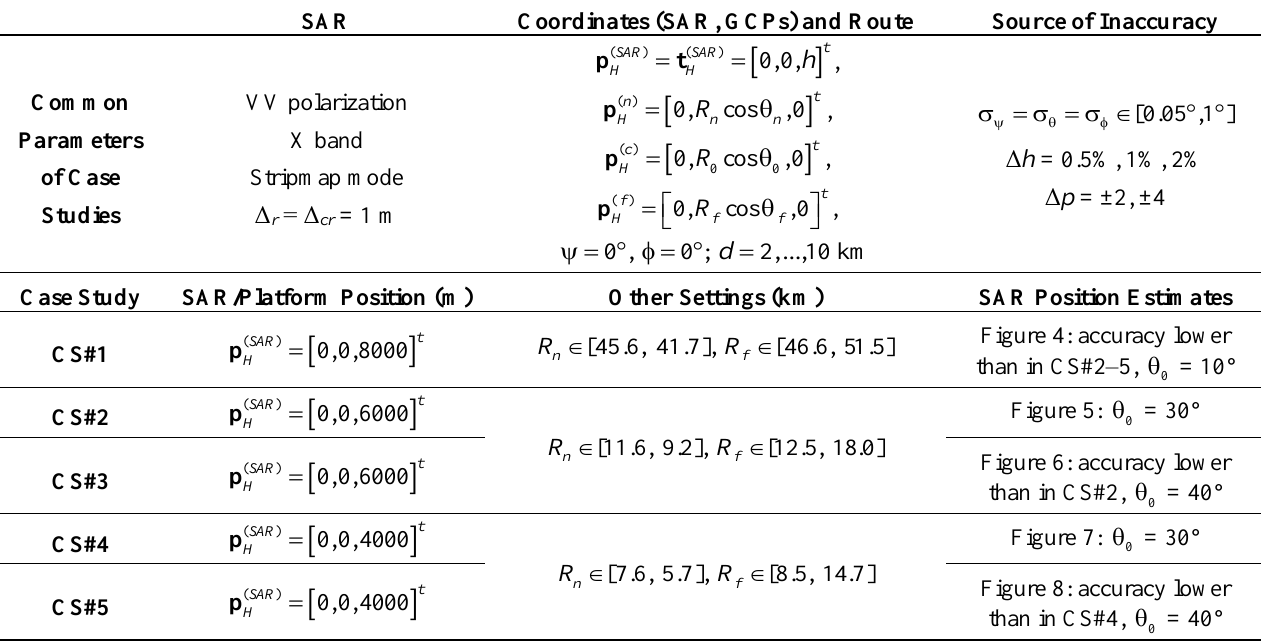
Table 2. Synthetic aperture radar (SAR) amplitudes-based approach: common parameter settings, case studies and results.